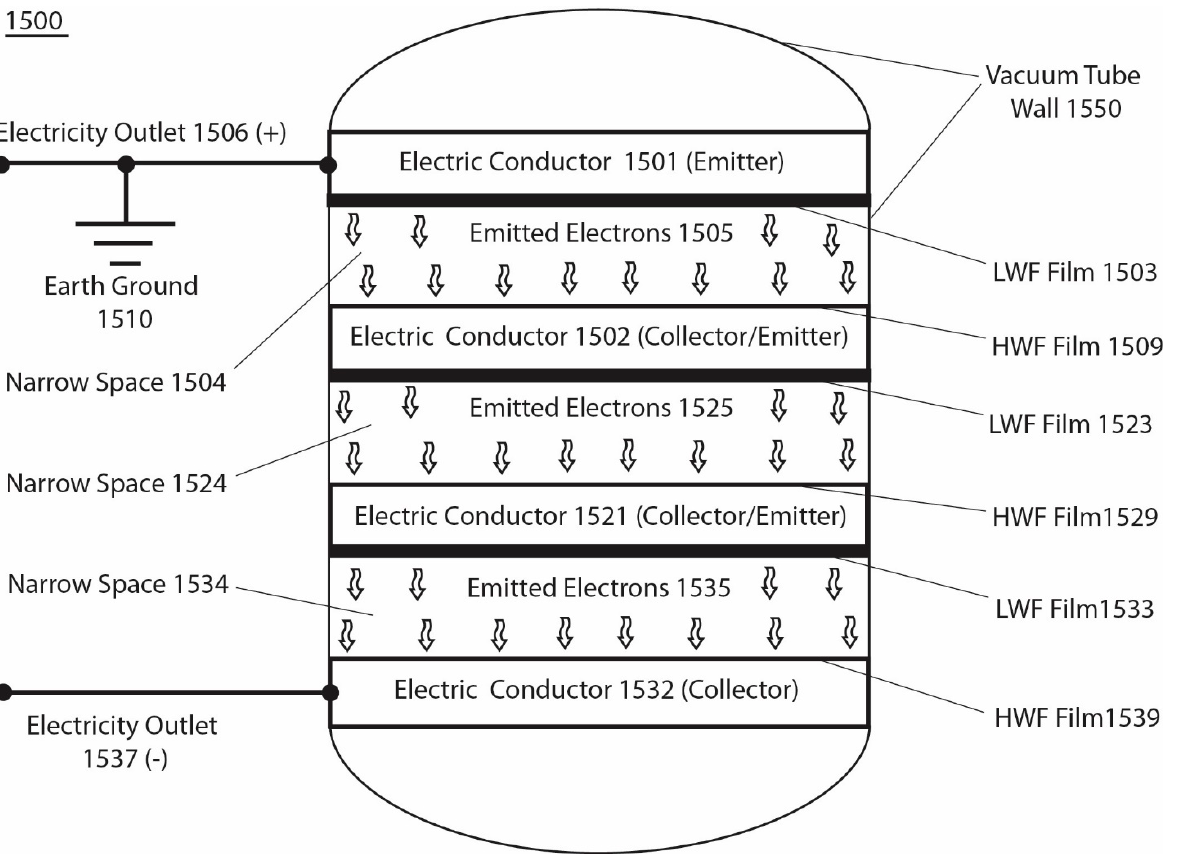
Figure 6. Presents an integrated isothermal electricity production system 1500 that comprises a narrow inter electrode space gap size for each of the three pairs of low work function emitters and high work function collectors installed in a vacuum tube chamber set up